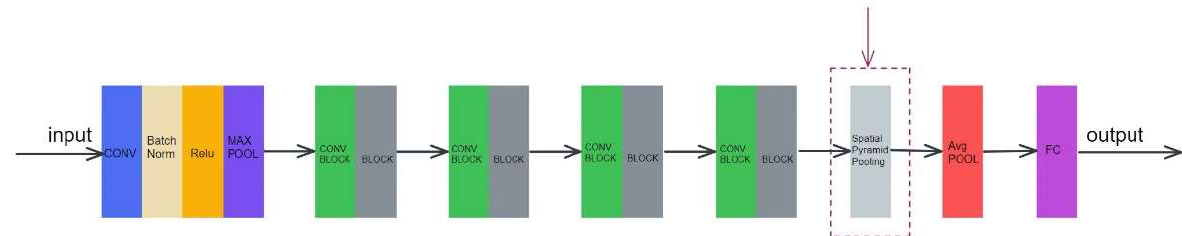
Figure 6. The model of ResNet + SPP.